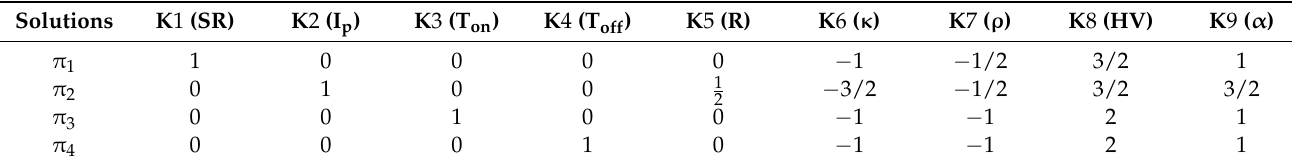
Table 7. Dimensional analysis